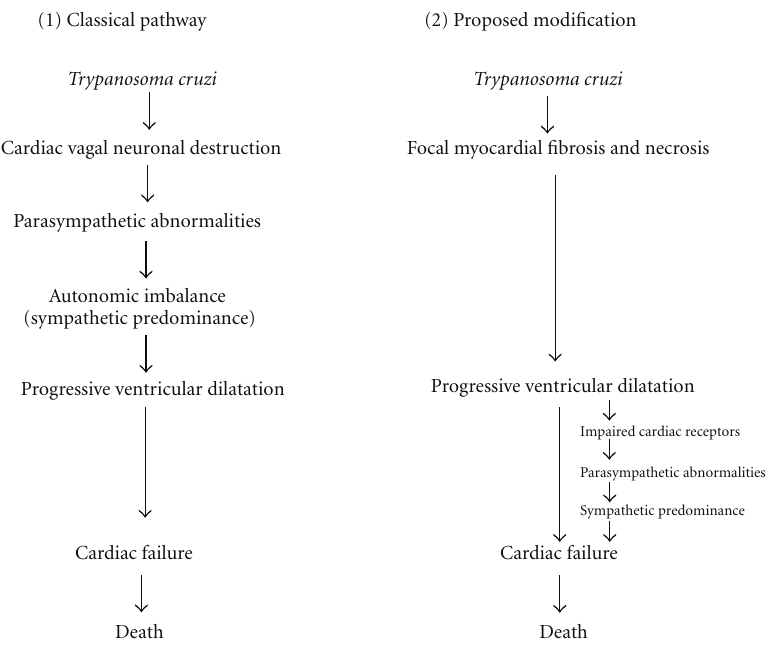
Figure 1: The neurogenic hypothesis on the pathogenesis of myocardial damage in chagas disease. According to the classical pathway, sympathetic activation, due to an early and selective destruction of the cardiac postganglionic neurons, would precede and induce cardiac ventricular dilatation. The proposed modification states that myocardial damage of certain extent and sequelae of the acute phase of the disease leads to progressive ventricular dilatation with impairment of cardiac receptors, parasympathetic abnormalities, and sympathetic activation (see [15]; 5: 327-29, adapted with permission from